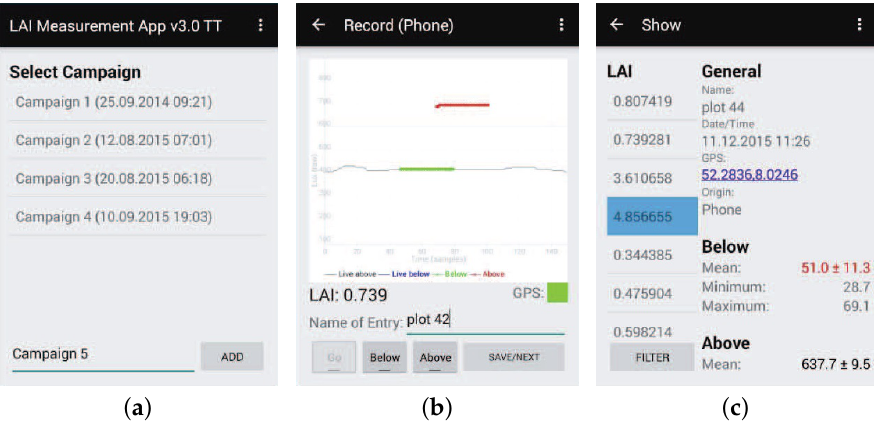
Figure 27. Smart fLAIr: ( a ) Main menu; ( b ) Measurement interface with LAI reading; ( c ) Measurement table with LAI readings and